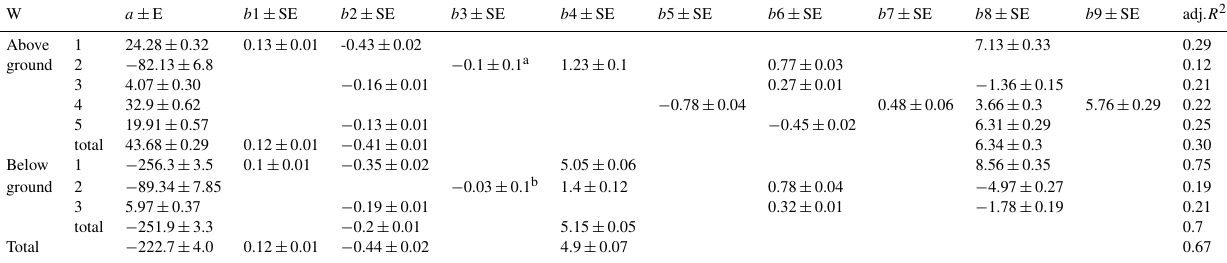
Table C1. Parameter estimates and their standard errors for the coefficients of the forest understory vegetation dry weight biomass (kgha − 1 ) models (Eq. C1) for functional types (1 – dwarf shrubs, 2 – herbs, 3 – grasses, 4 – mosses, and 5 – lichens) with intercept ( a ) and n –